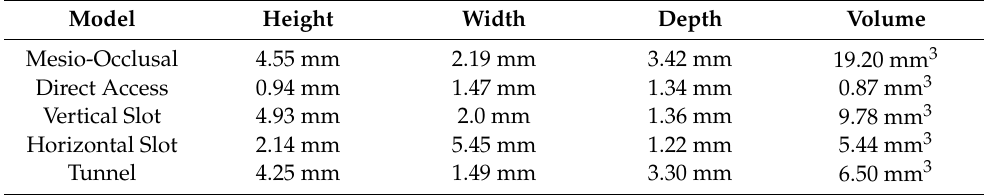
Table 1. Design inputs for each different type of proximal cavity simulated in the present study.